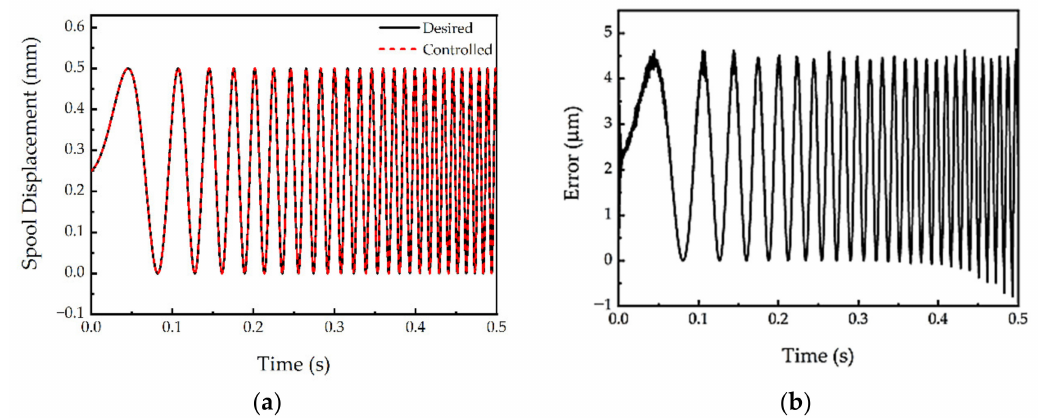
Figure 15. Tracking control of the spool displacement for the chirp signal from 1 Hz to 100 Hz (100 ◦ C); ( a ) tracking displacement, ( b ) tracking error.